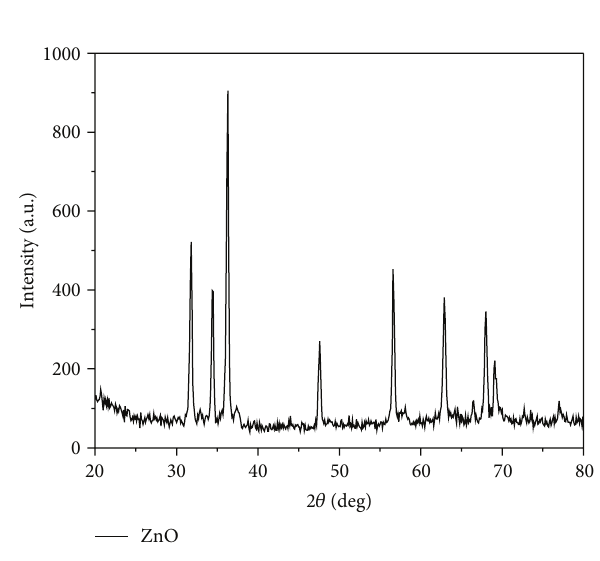
Figure 4: XRD of nano-ZnO.